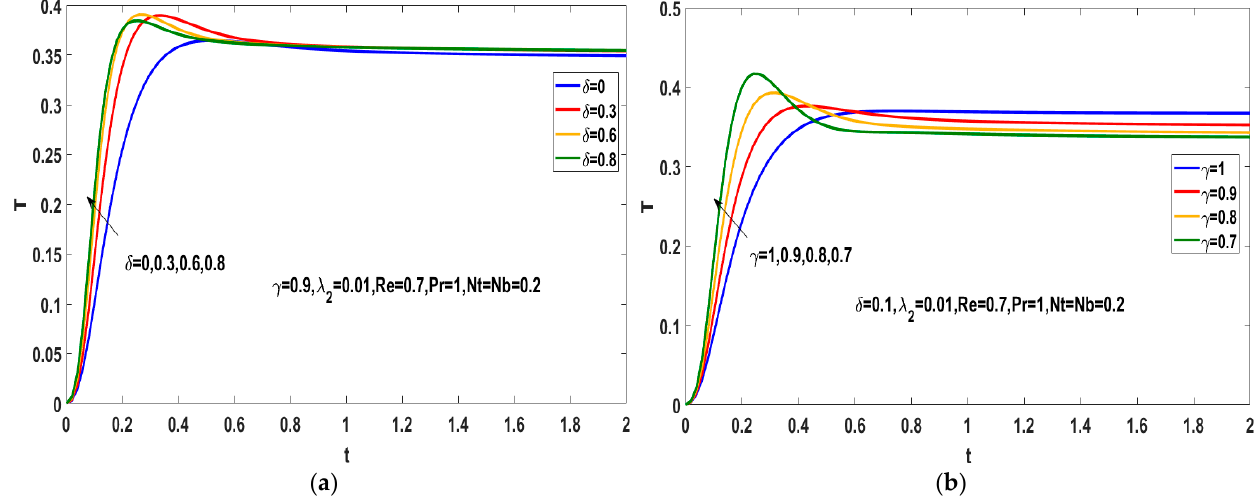
γ . Figure 4. Temperature distributions with respect to t : ( a ) for different δ ; ( b ) for different γ